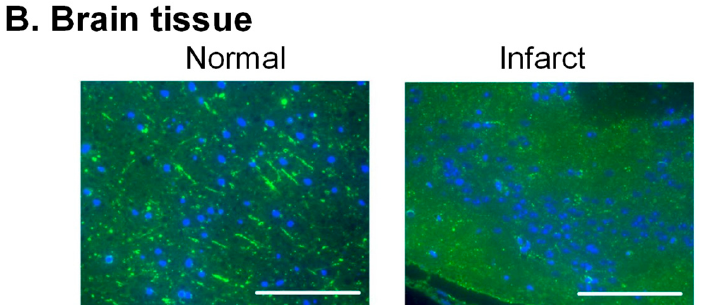
Figure 3. Change of the structure of cytoskeleton proteins through acrolein conjugation. ( A ). Neuro2a cells were cultured with 10 μ M acrolein, fixed at 0 and 24 h, while intermediate (vimentin) filament was stained with anti-vimentin antibody ( a ), and microfilament (actin) was stained using Alexa Fluor 488 conjugated phalloidin ( b ). Microtubules ( β -tubulin) were stained using anti- β -tubulin antibody ( c ). Bar = 10 μ m. ( B ). A mouse brain was taken out at 24 h after induction of ischemia, and microtubules were stained using anti- β -tubulin antibody. Bar = 100 μ m. Reprinted with permission from Ref. [33]. 2020 John Wiley and Sons and Ref. [36]. 2019 Elsevier.